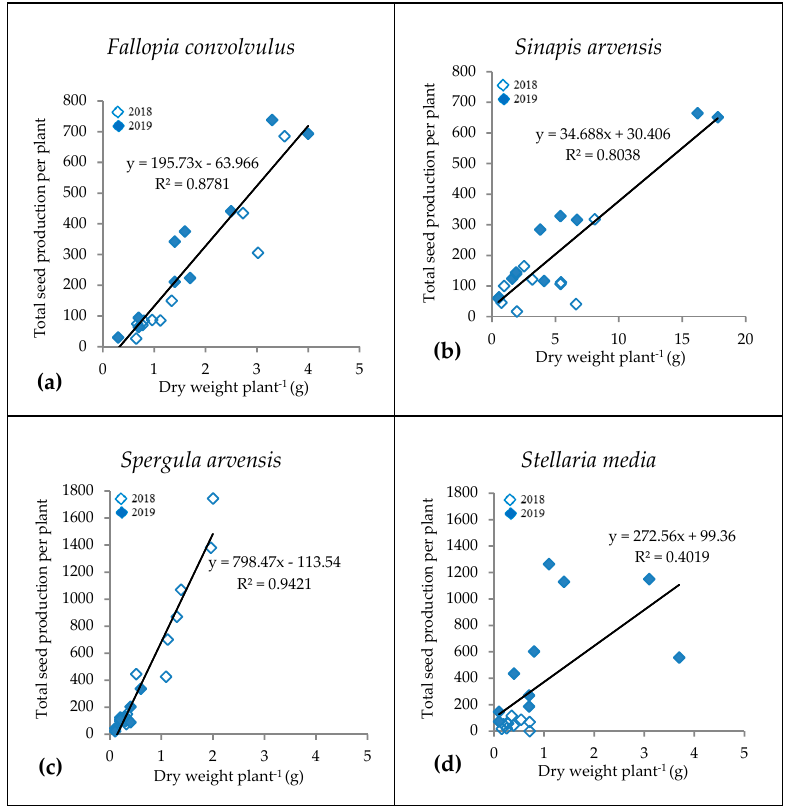
Figure 7. Total seed production per plant of ( a ) Fallopia convolvulus , ( b ) Sinapis arvensis , ( c ) Spergula arvensis and ( d ) Stellaria media as a function of the plant dry weight in 2018 and 2019.